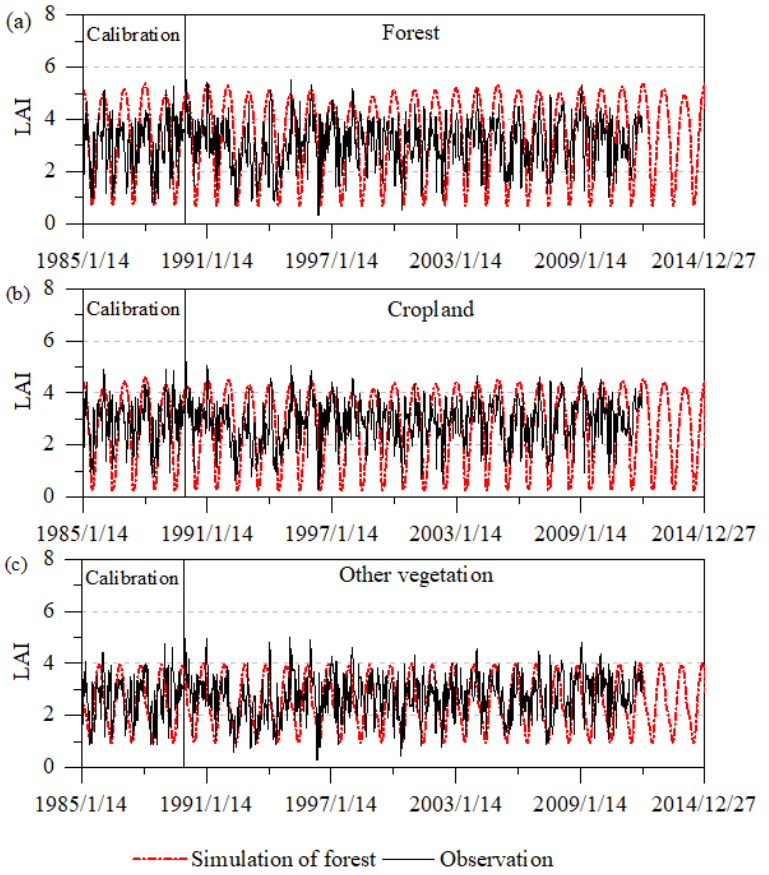
Figure 6. The comparison between the daily simulated areal mean LAI by the Biome-BGC model and the half-monthly remote sensing-based LAI (referred to as the observation in the figure) for forest ( a ), cropland ( b ), and other vegetation ( c ).